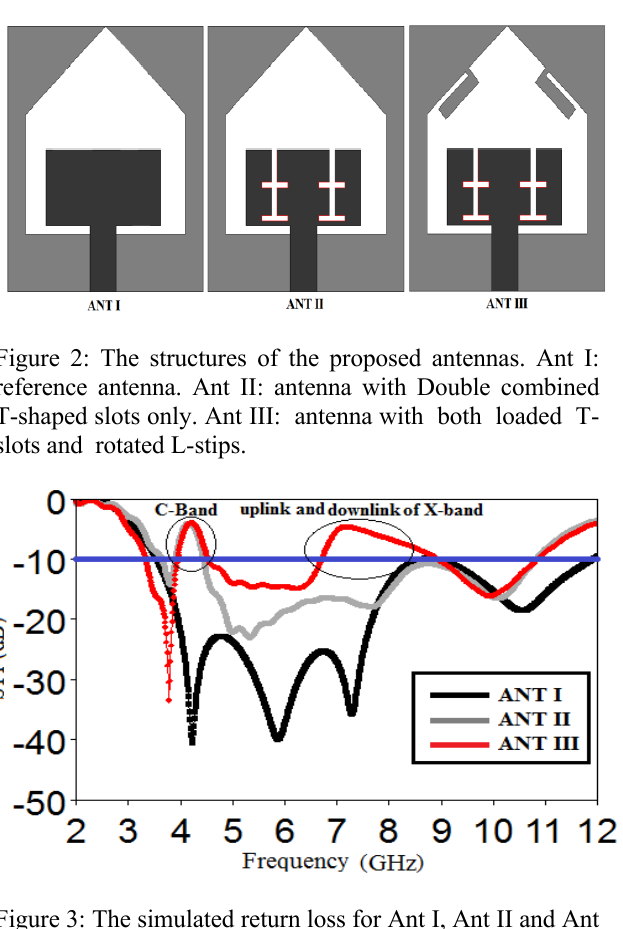
The Rejected C-Band